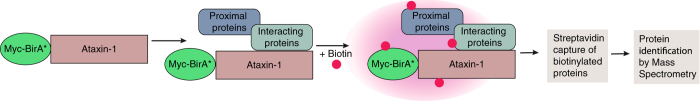
Principle of BioID screening of ataxin-1 proximal or interacting partners.The recombinant protein comprised of ataxin-1[85Q] fused to BirA* biotin ligase enables the biotinylation of directly-interacting or proximal proteins followed by capture on streptavidin-agarose, purification and mass spectrometry analysis for protein identification.